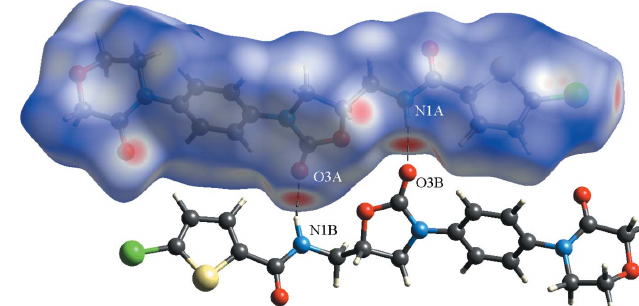
Figure 2 The supermolecular structure showing the intermolecular interactions (Table 2) as dashed lines.